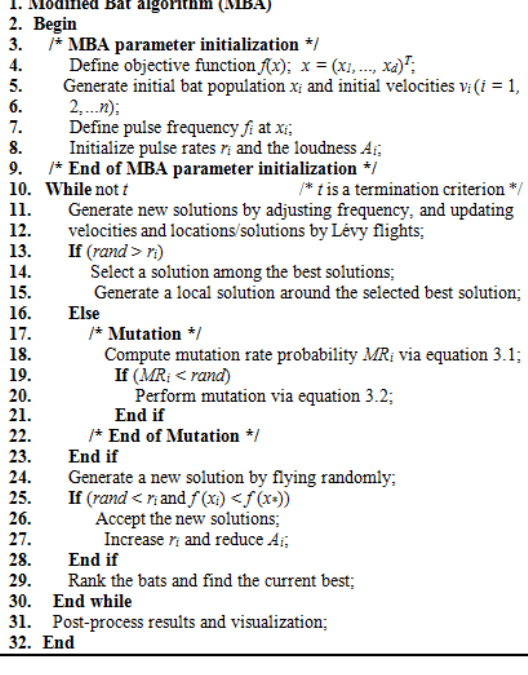
Figure 3: The general pseudo–code for MBA